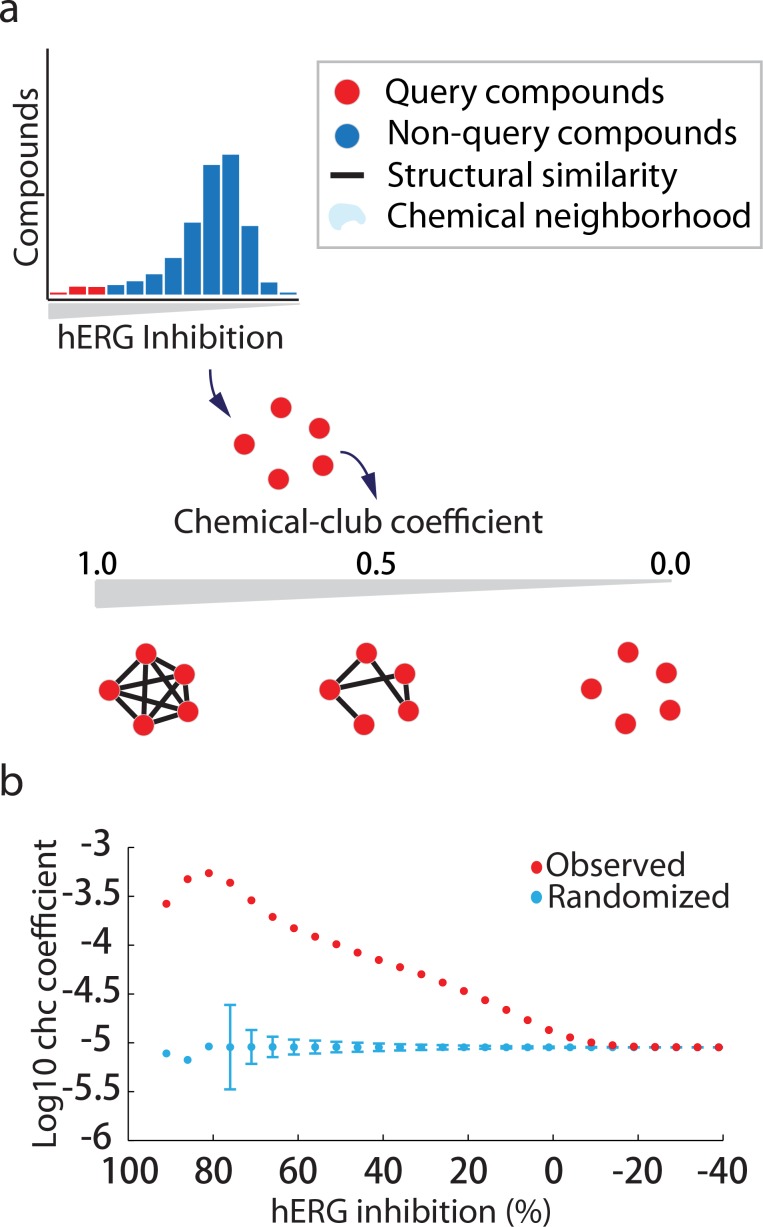
Potent hERG blockers exhibit preferential structural similarity.(a) Schematic diagram of chemical structure network analysis. The chemical-club coefficient (ChC) measures the density of connections (structurally similar pairs) among query compounds (red nodes) above a given threshold of hERG inhibition (top, red bars). (b) ChC calculation plotted for the MLSMR library for randomized (blue, mean +/- 3 standard deviations for randomized datasets) and observed (red) activity for 10 μM data, where compound adjacency is judged by a Tanimoto Coefficient > 0.7 for FCFP_6 circular fingerprints.